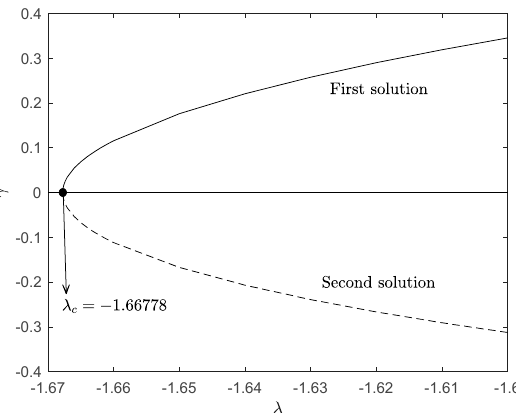
Figure 17. Smallest eigenvalue γ versus λ . Table 5. Smallest eigenvalues γ for selected values of ϕ 2 and λ .